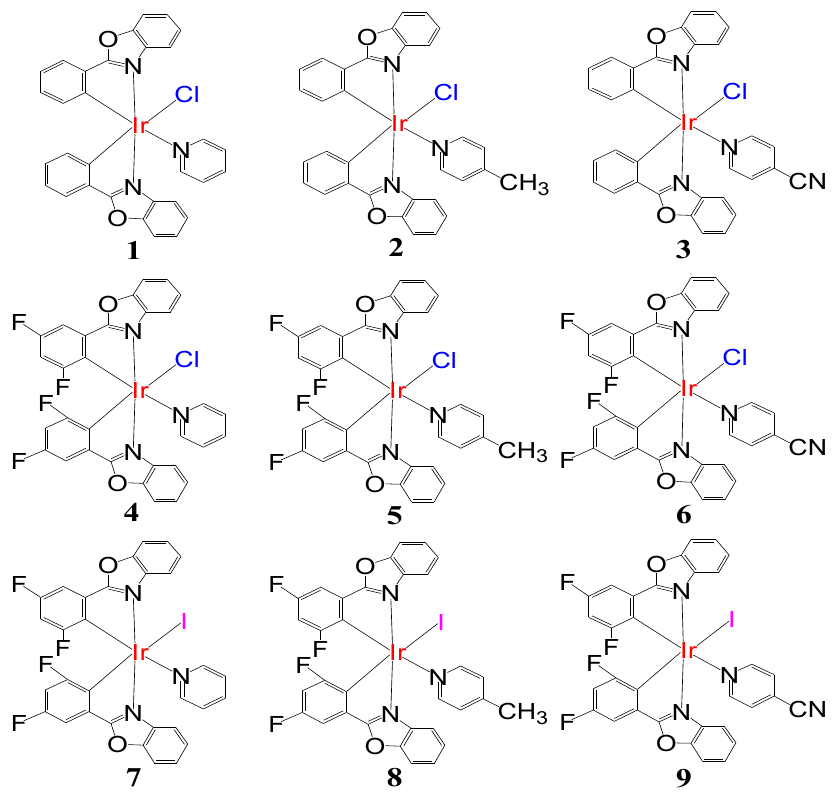
Chart 1. Molecular structure of complexes 1 – 9 .